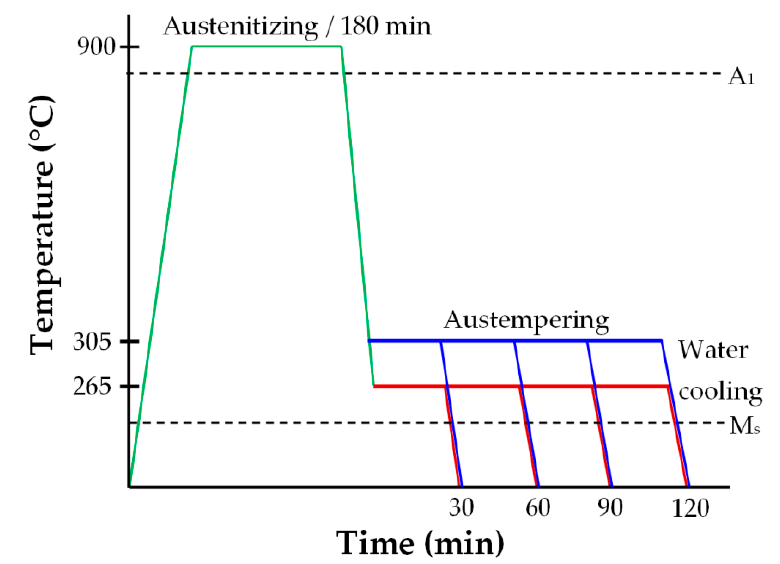
Figure 3. Austempering heat treatment cycles for temperatures of 265 and 305 °C.